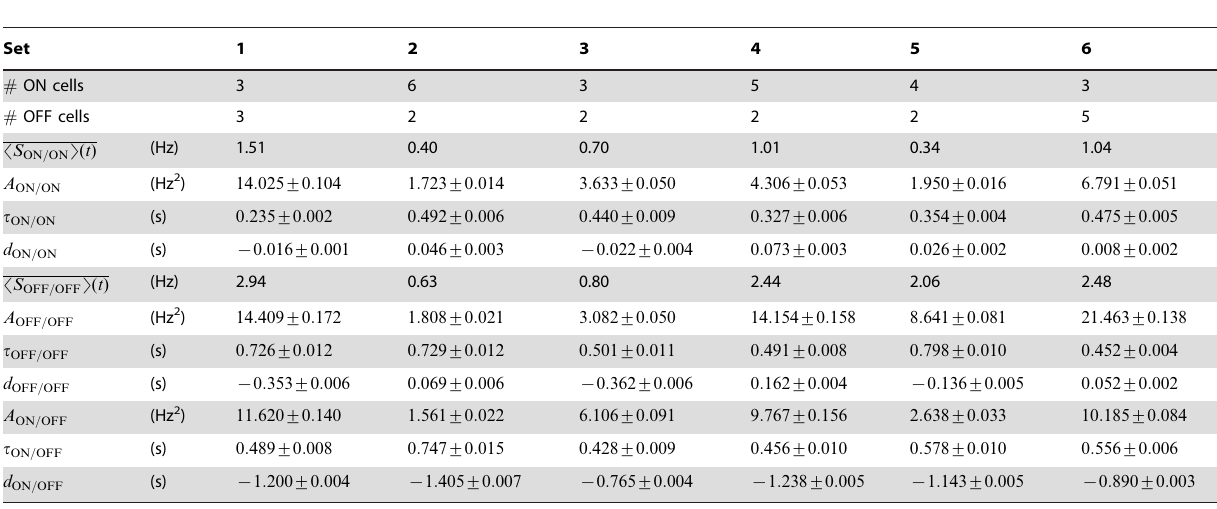
The number of ON and OFF cells used in the simulated integrate-and-fire model are also listed for each data set. The OFF/ON correlation function is a reflection about 0 of the ON/OFF correlation function, such that A OFF = ON ~ A ON = OFF , t OFF = ON ~ t ON = OFF and d OFF = ON ~{ d ON = OFF .